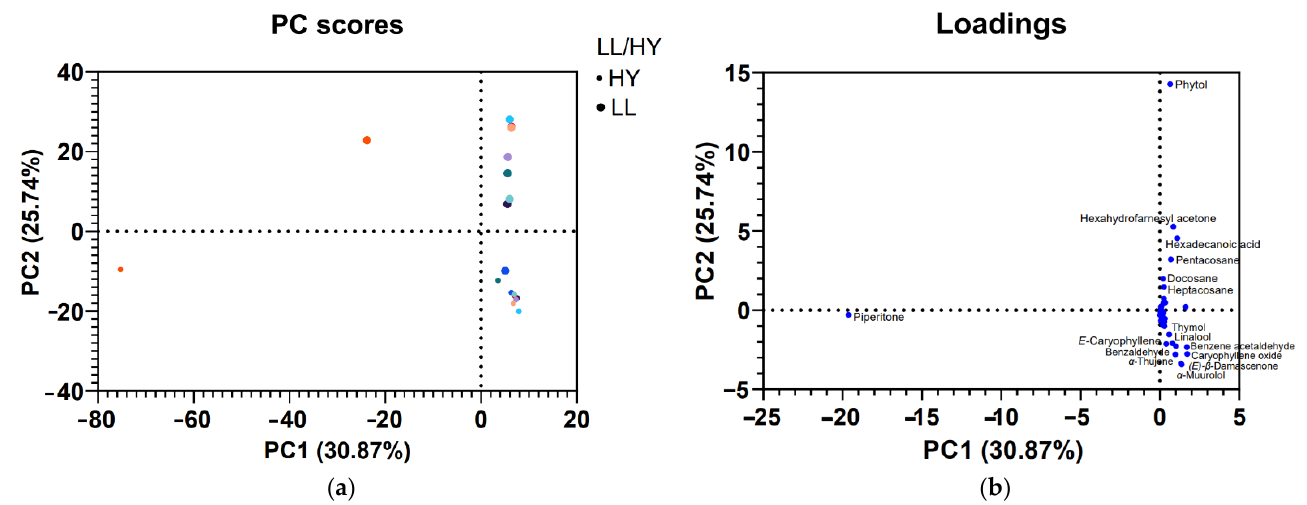
Figure 4. ( a ) PCA score plot for LLs and hydrosols from MAE method; ( b ) PCA loading plots of MAE volatiles from the first and second principal component. The color palette represents the same species as in Figure